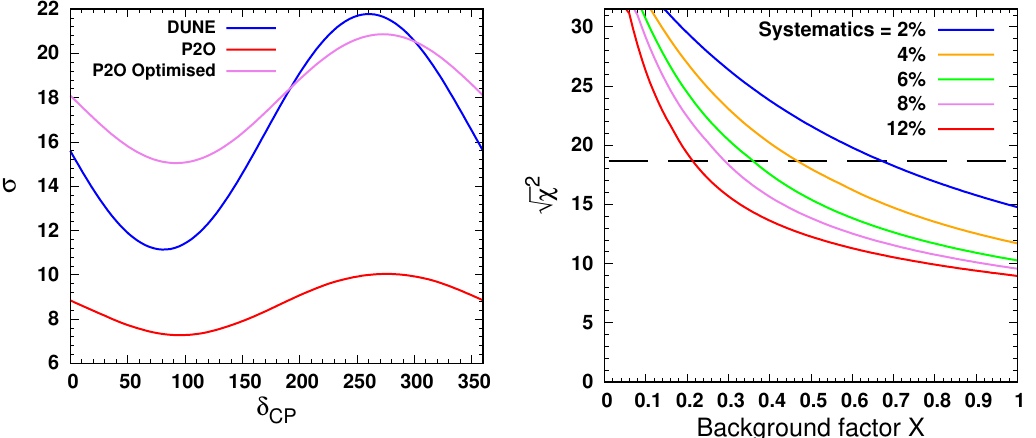
Figure 2 . Hierarchy sensitivity as a function of true δ CP (left panel) and as a function of background reduction factor X (right panel). These panels are generated for true normal hierarchy.